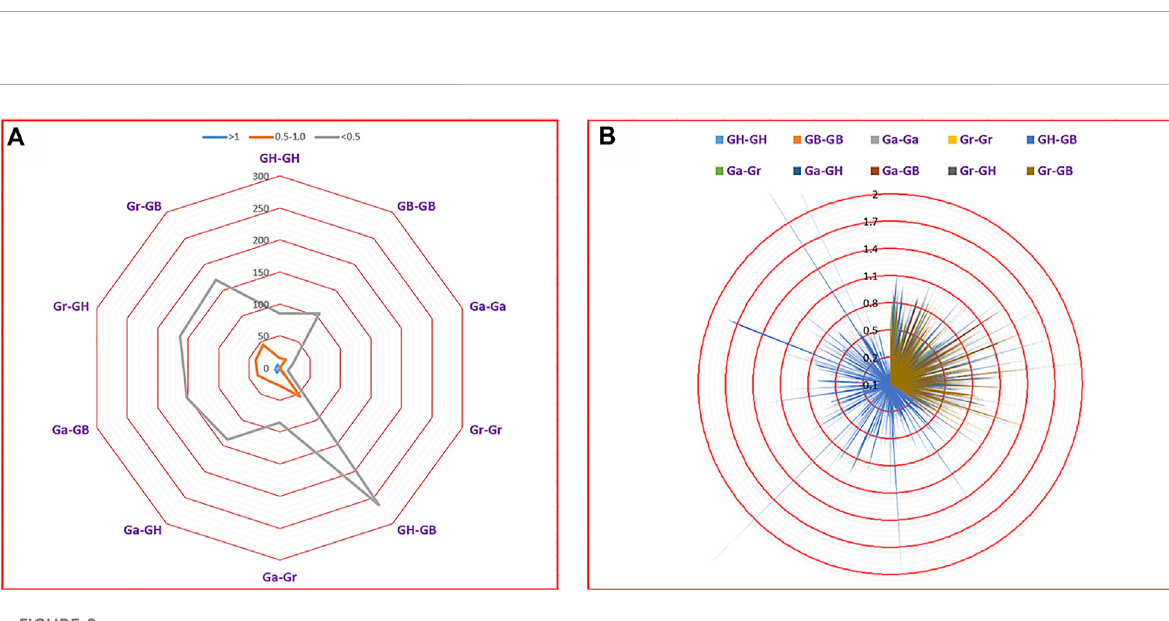
species, which laid the foundation for the polyploidy and large-scale expansion of the UGT gene family during evolution.